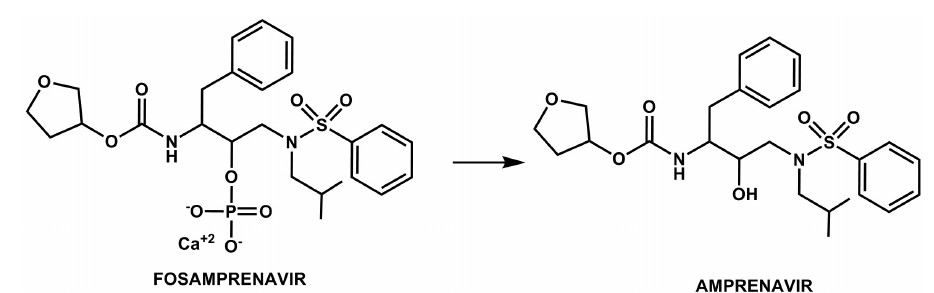
FIGURE 16 - Fosamprenavir structure (prodrug) and its conversion into amprenavir . of tenofovir disoproxil fumarate, promoted by esterases, stechiometrically generates four types of molecules: iso- propanol, carbon dioxide, formaldehyde and tenofovir (Larsen et al. , 2004).